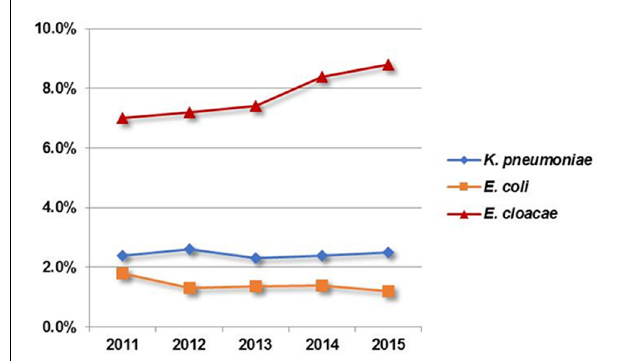
FIGURE 1 | Distribution of carbapenem resistant Enterobacteriaceae from 2011 to 2015 according to the Chongqing Resistance Monitoring Network.